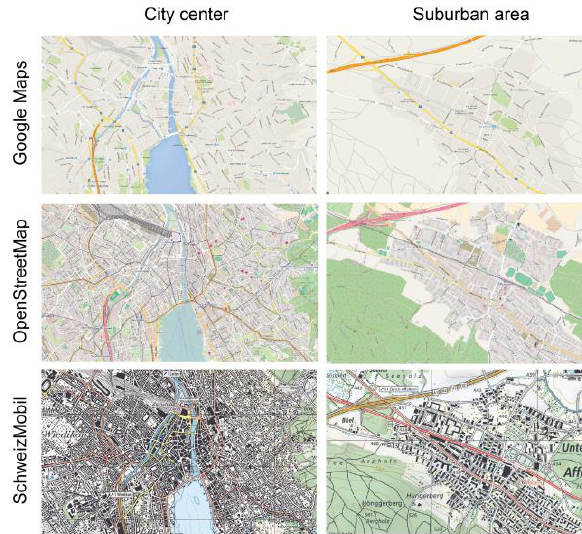
Figure 2. Analyzed city maps in the Phase 2.